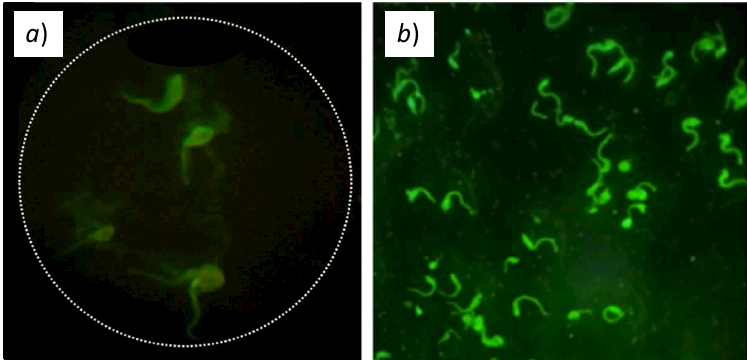
Figure 12. Fluorescence images of T. cruzi parasites labeled with FITC fluorophore, obtained with ( a ) our inverted fluorescence microscope; ( b ) a commercial Motic BA410E fluorescence microscope.